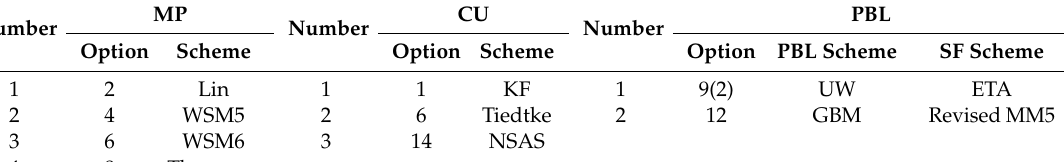
Table 3. Selected physics schemes at the fourth round of scheme screening.